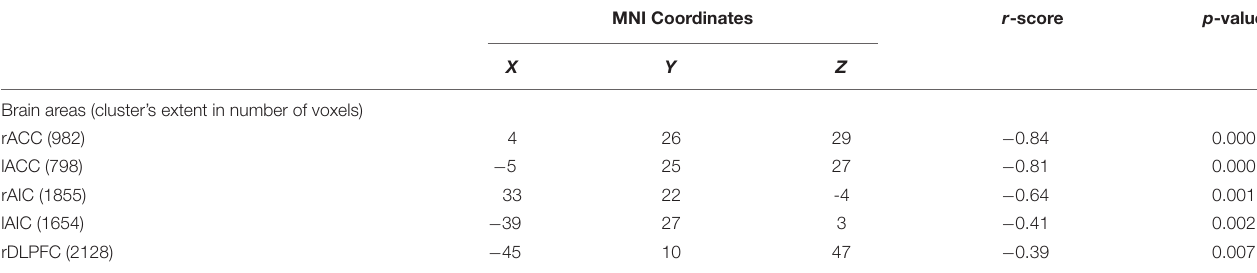
TABLE 4 | Linear correlation between the “NoGO” vs. “GO” contrast and DS-I scores (FWE p < 0.05). MNI Coordinates r -score p